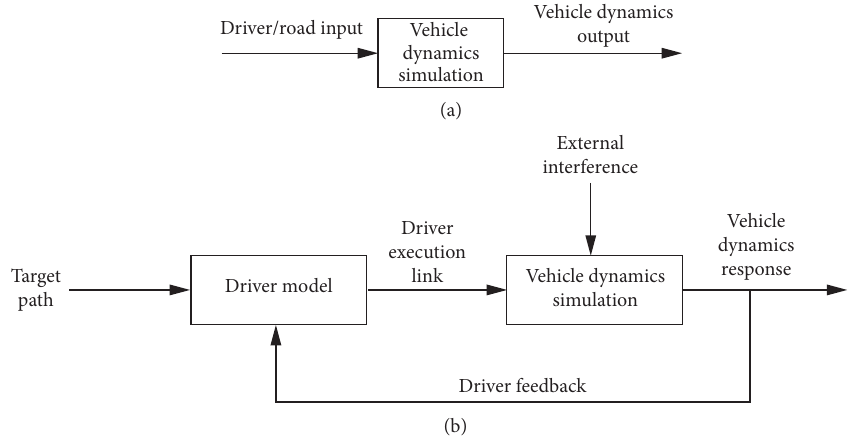
Figure 3: Flow chart of simulation. (a) Open-loop simulation. (b) Closed-loop